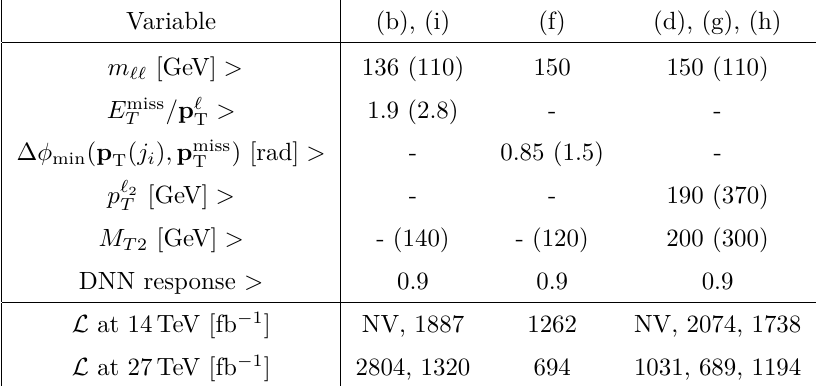
Table 9 . The analysis cuts on a set of kinematic variables at 14 TeV (27 TeV) grouped by the benchmarks of table 6. Notice that with the exception of m ‘‘ harder cuts are applied at 27 TeV. Entries with a dash (-) mean that no requirement on the variable is considered. Also shown at the bottom are the required integrated luminosities for discovery at 14 TeV and 27 TeV. Entries with ‘NV’ mean that the point is not visible at the corresponding center-of-mass